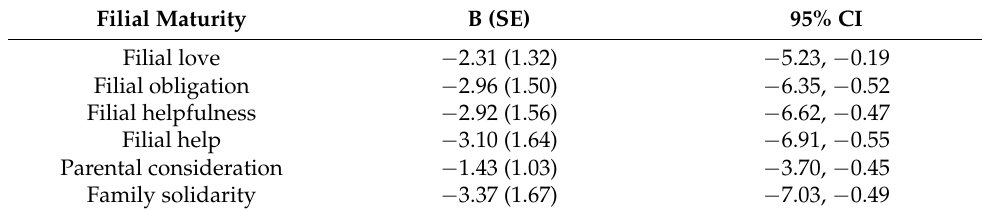
Table 3. Indirect Effects for Well-Being, with RDQ Total Score and Filial Maturity ( N =